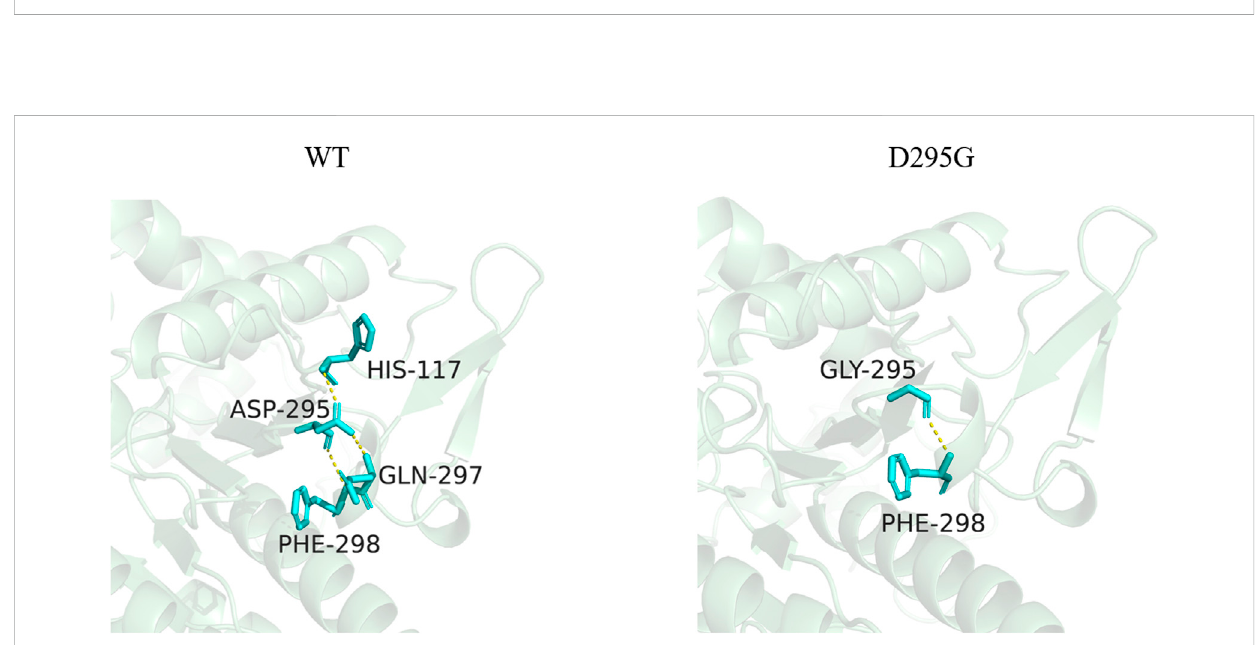
FIGURE 6 Changes of hydrogen bonds between amino acid residues at position 295 and surrounding amino acids before and after mutation. The yellow dotted lines in the fi gure represent hydrogen